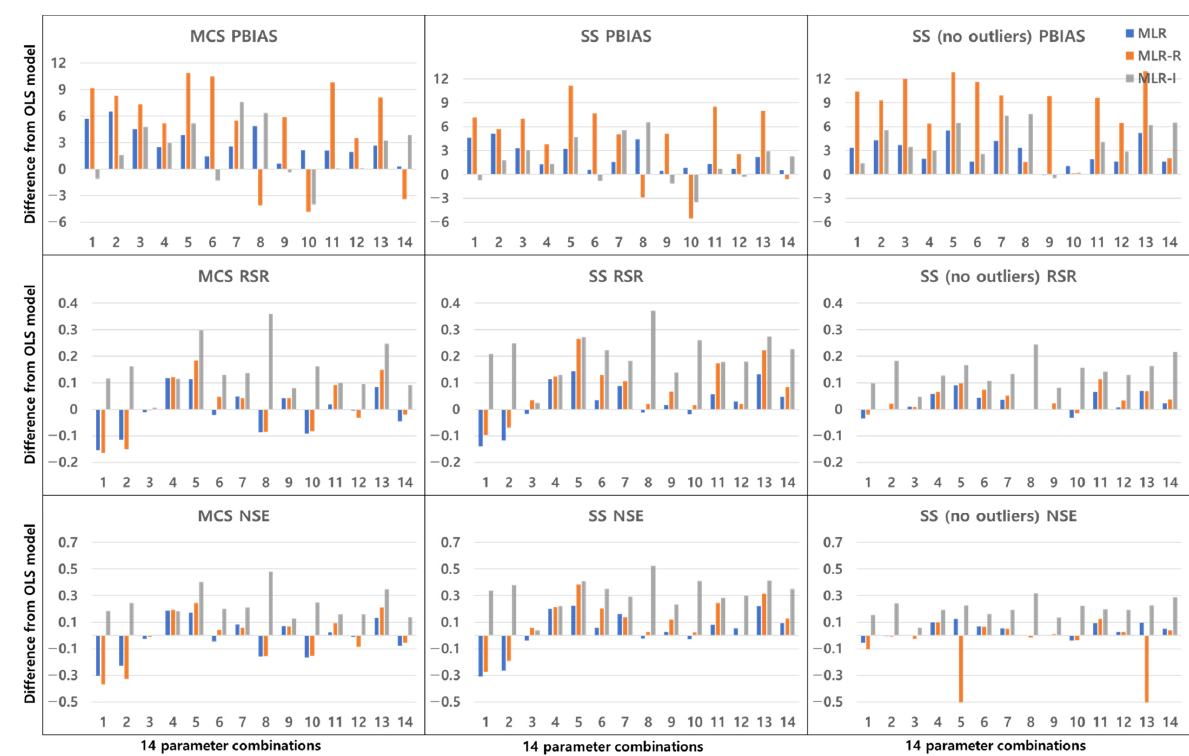
Figure 19. Differences between the OLS model and the other three MLR models by averaging the values of the model evaluations with the three sampling methods for TP removal in retention ponds.